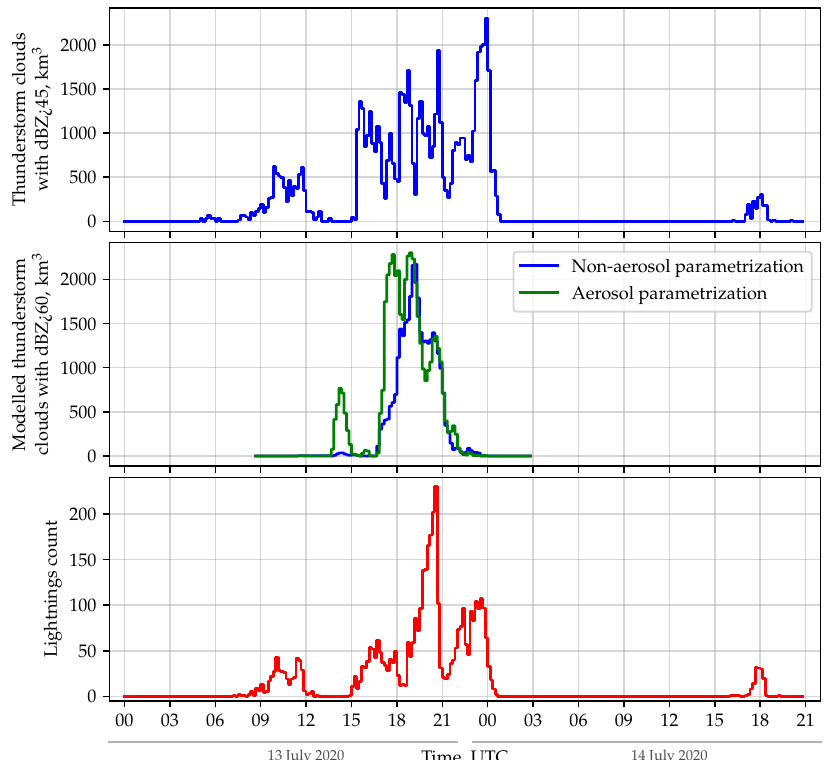
Figure 11. Upper panel: volume of thunderclouds (sum of volume cells) observed by meteorological radar with radar reflectivity more than 45 dBZ. Central panel: volume of thunderclouds with simu- lated reflectivity more than 60 dBZ. Lower panel: number of lightning discharges in 210 domain every 10 min according to the WWLLN